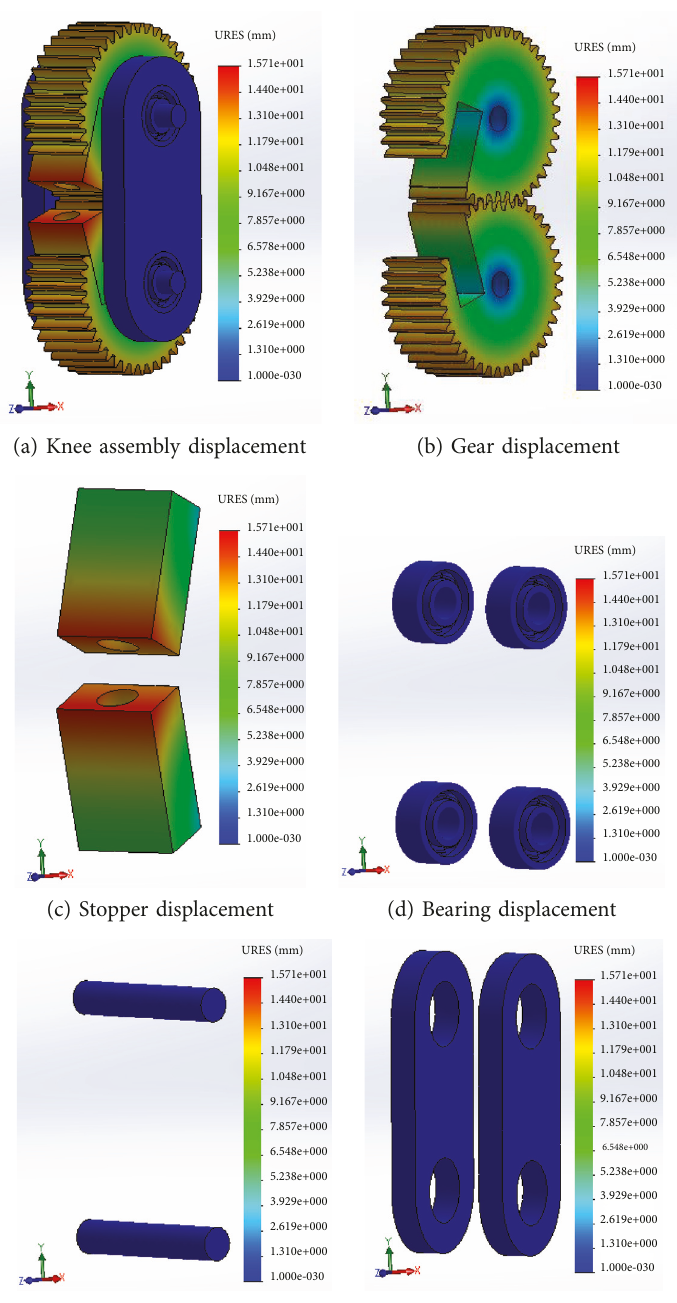
Figure 10: Displacement analysis of the knee joint